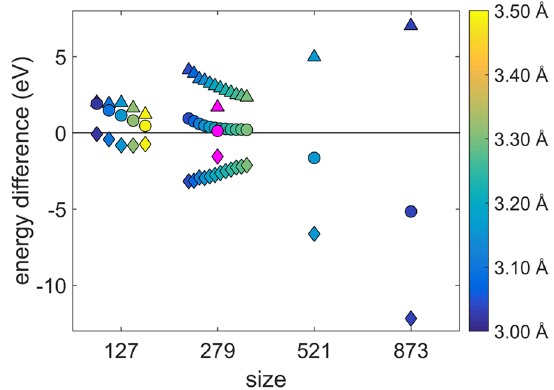
Figure 3. Plot of ∆ parameters as a function of size. ∆ − triangle and circle markers respectively. The ∆ parameters at sizes 127 and 279 are shown for the same multiple chiral structures as indicated in the Fig. 2. The color coding indicates the maximum bond length of the new Ag-Ag bonds in the chiral structure at each data point. There is an additional data point marked in magenta color which corresponds to the mean energy differences in the shell (diamond marker), the core (triangle marker), and the total structure (circle marker) observed in the chiral stacking with respect to the anti-Mackay stacking at 50